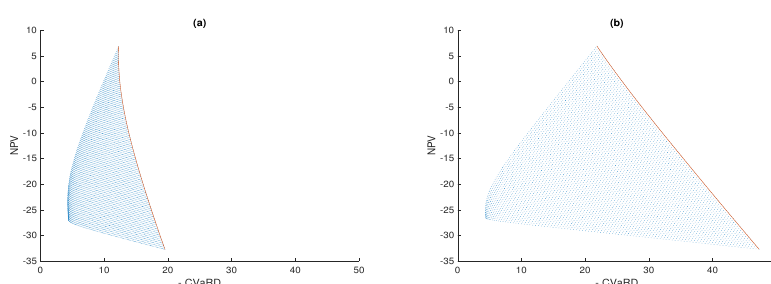
Figure 7. Power portfolio opportunity sets under the stochastic NPV metric: ( a ) the σ ca = 0.1 case; ( b ) the σ ca = 0.2 case. In the y -axis, NPV stands for expected NPV. Continuous red lines depict two-asset, gas and coal, portfolio opportunity sets.